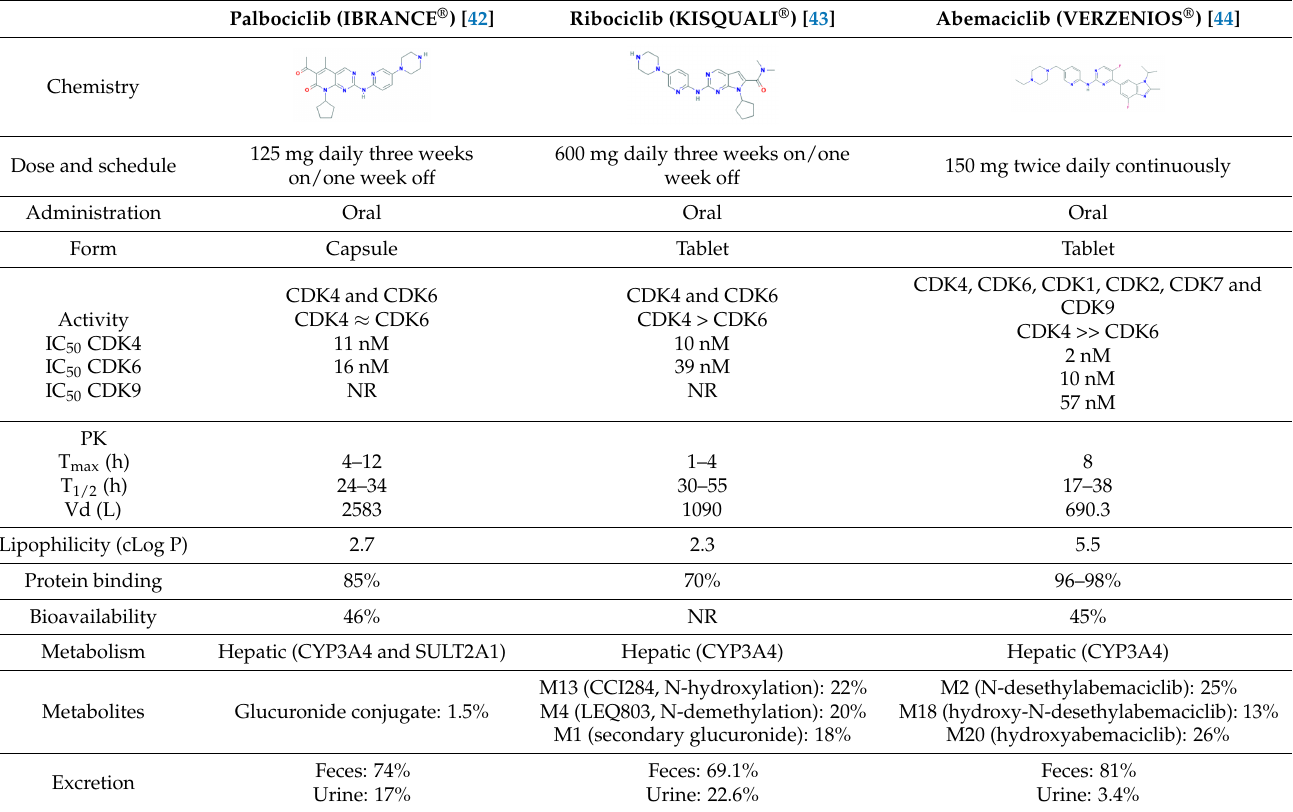
Table 1. Pharmacologic features of Palbociclib, Ribociclib, and Abemaciclib. Palbociclib (IBRANCE ® ) [42]